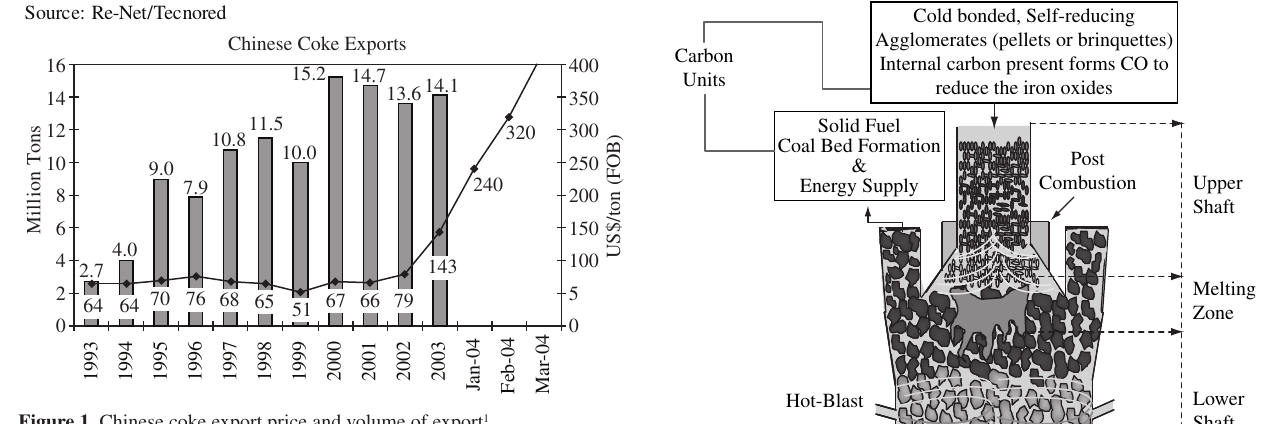
Figure 1. Chinese coke export price and volume of export 1 .